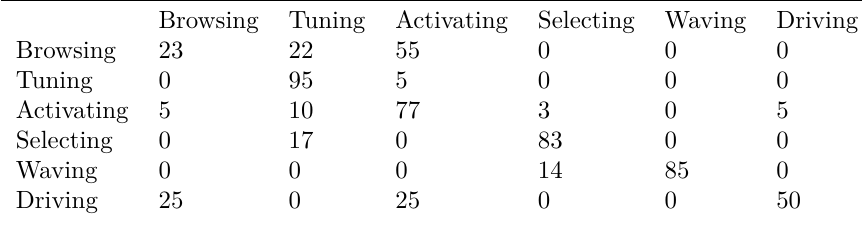
Table 3. Confusion matrix of selected driving actions.